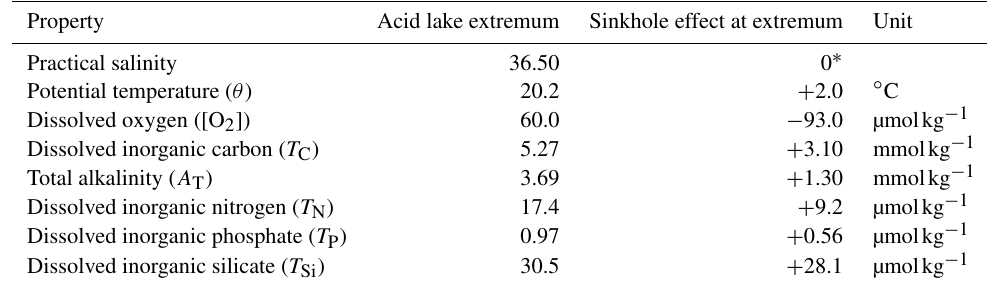
Table 1. Maximum sinkhole effects on acid lake seawater properties.